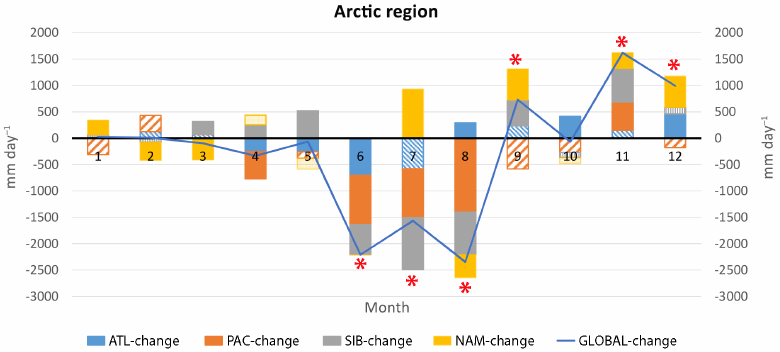
Figure 8. Differences between mean values of moisture transport for precipitation (MTP) until 2003 and mean values after 2003 for every source region. Filled bars show those differences that are statistically significant at the 95% confidence level for decreases after the CP. Statistical significance of the differences in total MTP (sum of the four sources) is displayed with a red